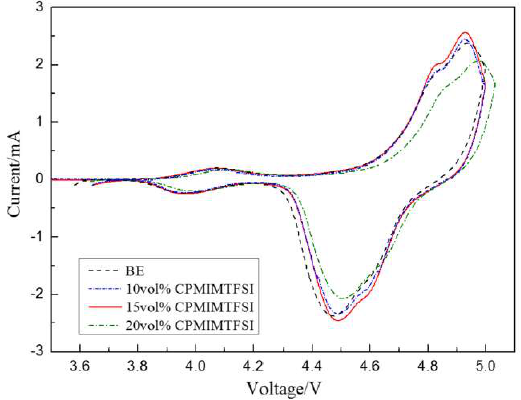
Figure 9. Cyclic voltammograms of LiNi 0.5 Mn 1.5 O 4 /Li cells after 30 cycles with different concentrations of [cpmim][NTf 2 ] at 0.1 mVs −1 . Reproduced with permission from [45], copyright 2020, Springer.